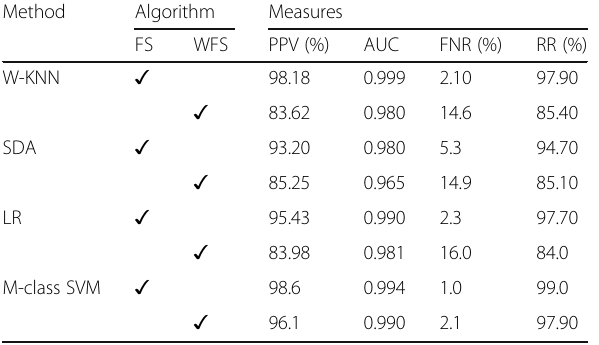
Table 13 Confusion matrix of Muhavi dataset (L